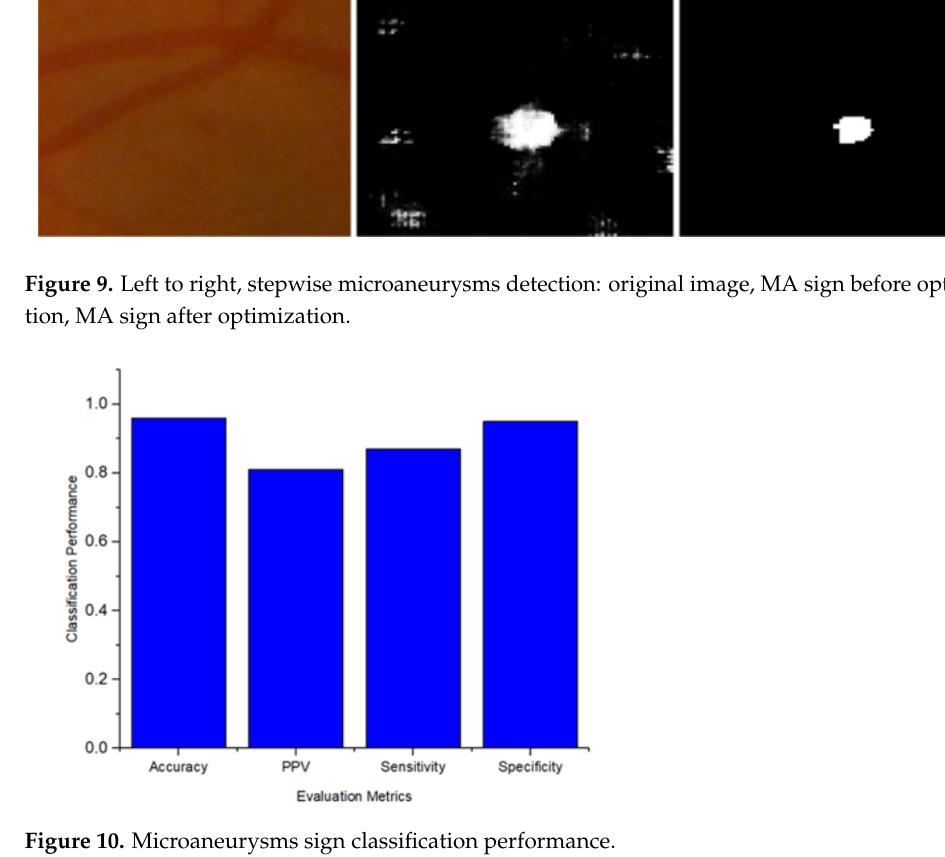
Figure 10. Microaneurysms sign classification performance.